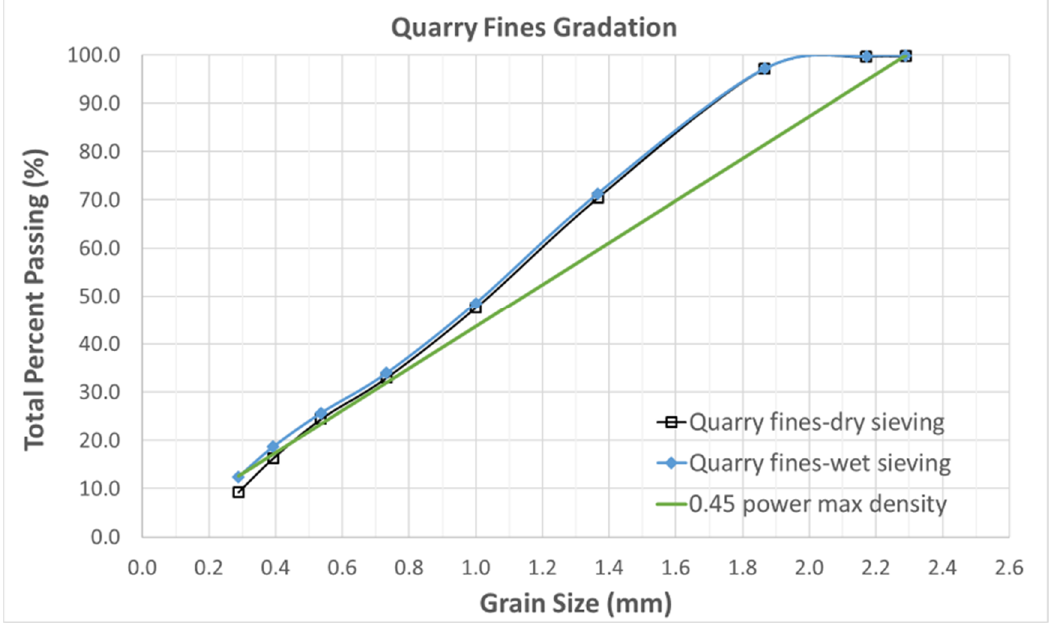
Figure 2. 0.45 power maximum density graph for quarry fines.